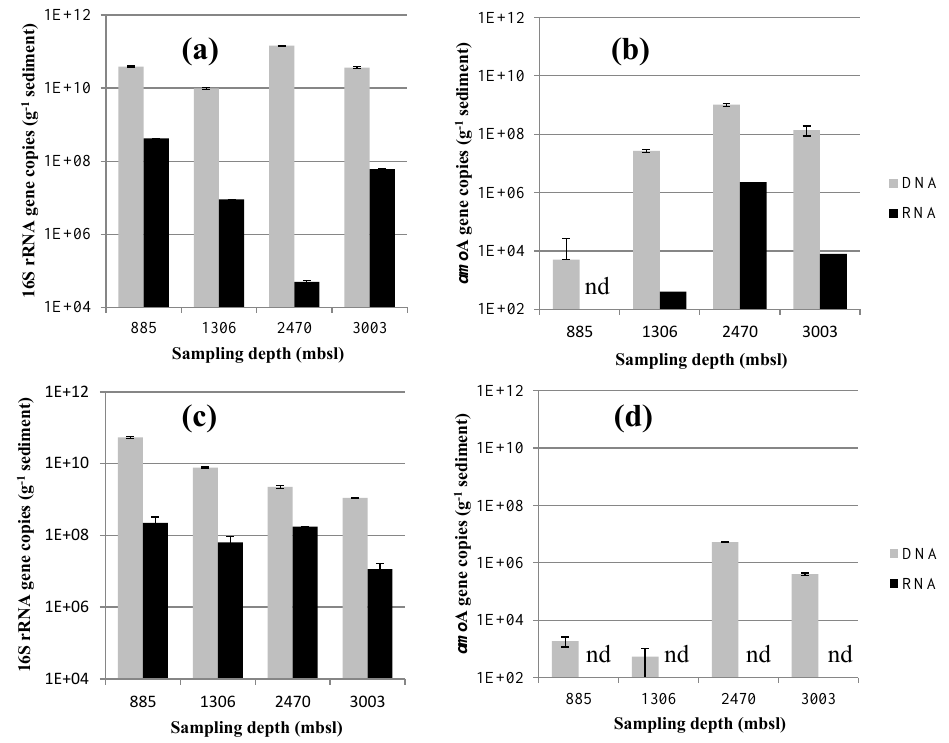
Figure 5. Abundance of Thaumarchaeotal 16S rRNA (a, c) and amo A (b, d) gene fragment copies per gram of dry weight in the surface sediment (0–0.5cm) (a, b) and the subsurface sediment (10–12cm) (c, d) . Black bars indicate the number of DNA 16S rRNA or amo A gene fragment copies and the gray bars indicate the RNA (gene transcripts) of 16S rRNA or amo A gene fragment copies. Error bars indicate standard deviation based on n = 3 experimental